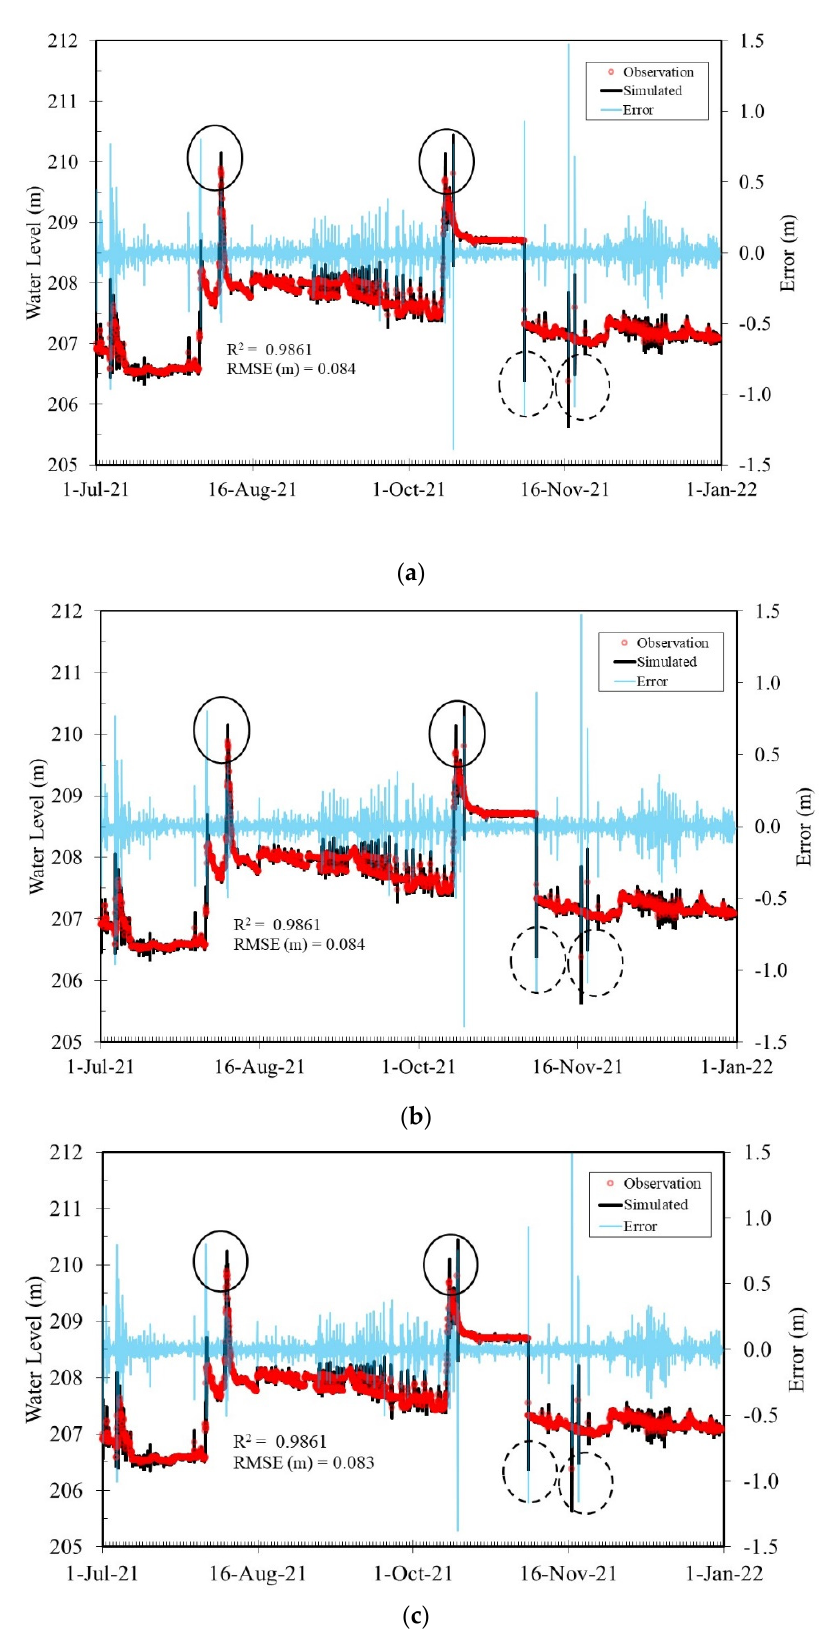
Figure 12. ( a - c ) Comparison of simulation and observed water levels at BR_S2 of the Beinan River for lead times t + 1 h, t + 2, and t + 3 h, respectively.